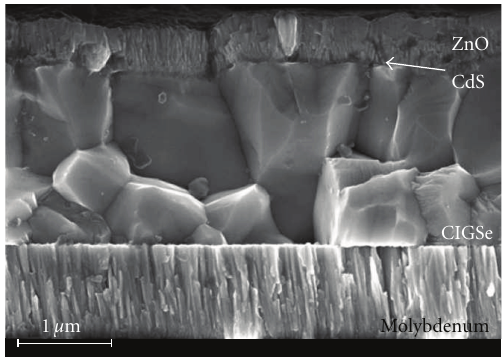
Figure 2: Scanning electron micrograph of the cross-section of a typical chalcopyrite solar cell with Cu(In,Ga)Se 2 (CIGSe) absorber (substrate now shown). Taken from [34].